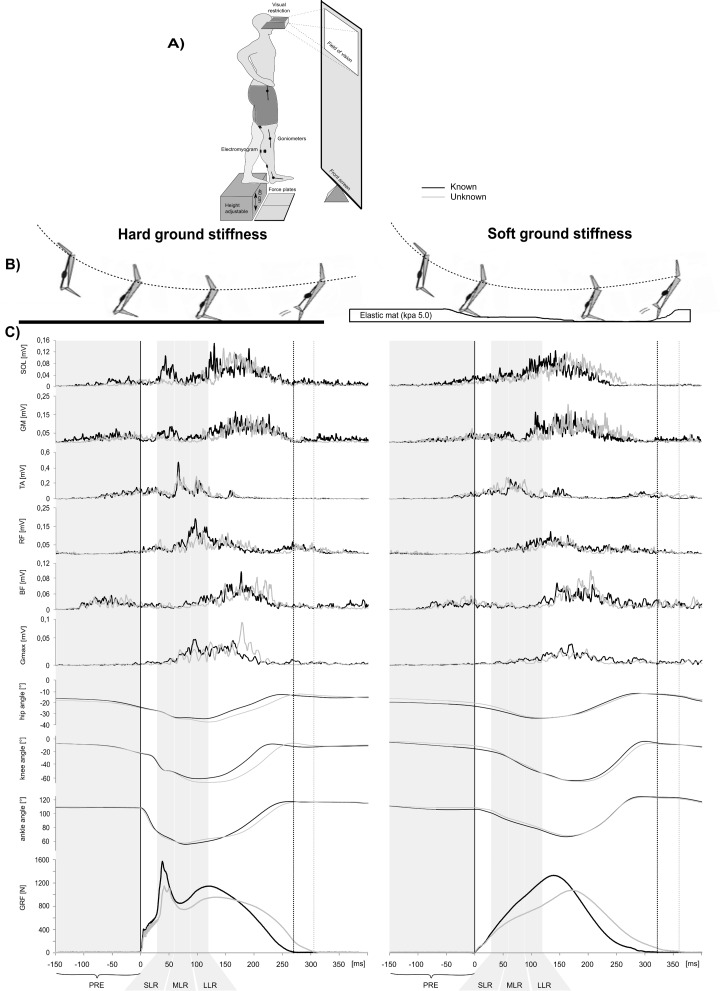
Experimental setting: Schematic illustration of stretch-shortening cycle and force, kinematic and electromyographic activity.(A) Experimental setting. (B) Schematic illustration of the stretch-shortening cycle with an active stretch (eccentric contraction) of a muscle, followed by immediate shortening (concentric contraction). (C) Modulation of the ground reaction force (GRF; bottom), ankle, knee and hip joint kinematics (middle) as well as electromyographic (EMG) activity of shank (SOL, GM and TA) and thigh muscles (RF, BF Gmax) for one representative subject in the known (solid line) and unknown condition (dotted line) on hard ground. GCT is marked as the time between GC and take-off; the relevant EMG phases PRE, SLR, MLR and LLR (bottom) are also marked. Data comprise the means of 15 jumps for each condition. EMG activity in shank and thigh muscles was mostly reduced in PRE, SLR, MLR and LLR from known to unknown. Concomitantly, GCT duration was lengthened, and the peak force decreased from known to unknown conditions.